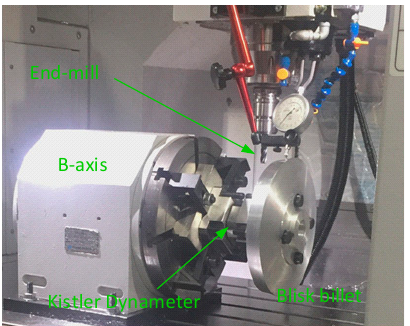
Figure 8. A Kistler dynameter is set up to measure the cutting forces.